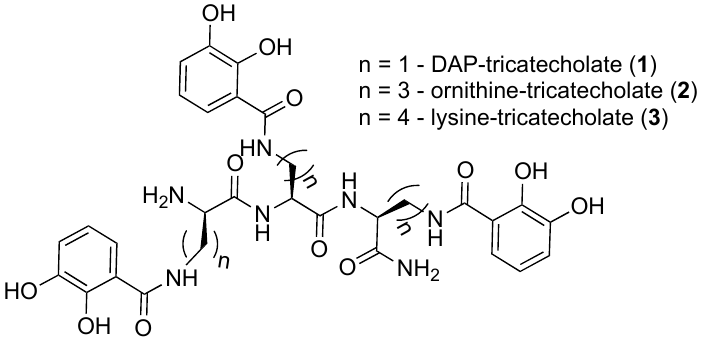
Figure 1. Structures of the synthesized tricatecholato-containing peptides.